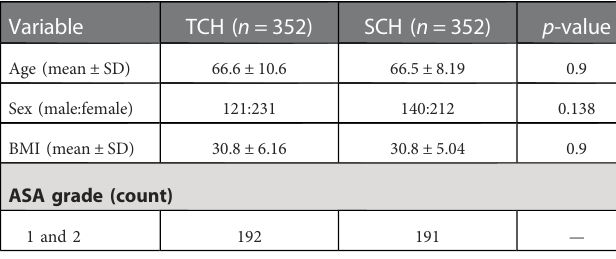
TABLE 1 Demographic variables of propensity-matched